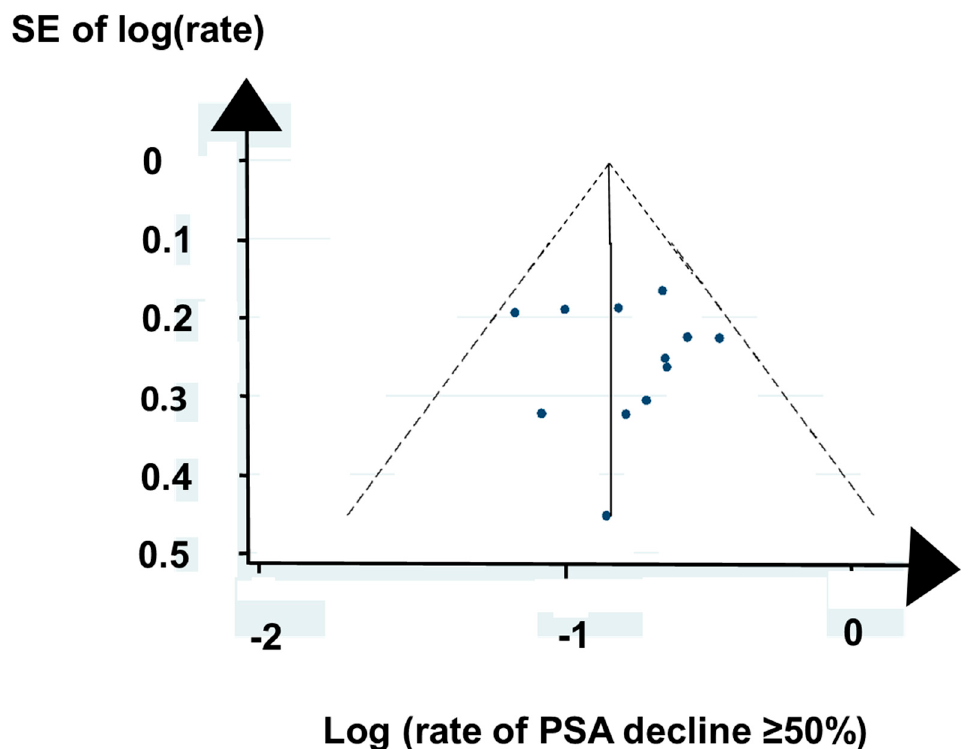
Figure 2. A Funnel plot of publications regarding PSA decline ≥ 50% with first series of 177 Lu PRLT indicates no evidence of bias.